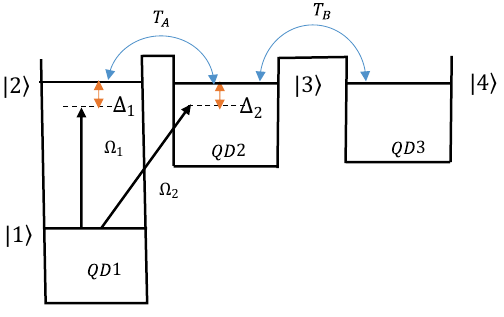
Figure 1. A four-level quantum dot molecule’s band diagram. A triple quantum dot molecule is made up of three dots (“QD 1,” “QD 2,” and “QD 3”) with different tunneling rates T A and T B . The corresponding energy level structure is denoted by levels